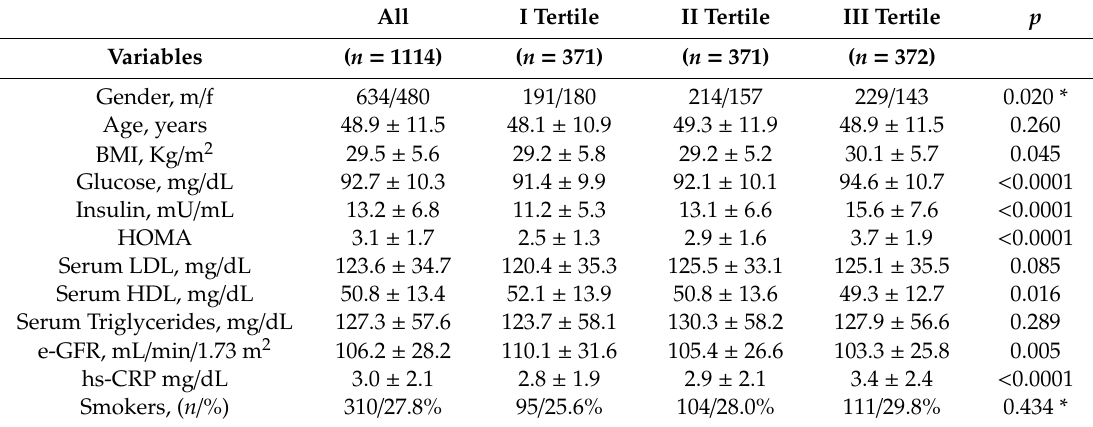
Table 1. Anthropometric and biochemical characteristics of the study population according to increasing tertiles of serum UA. All I Tertile II